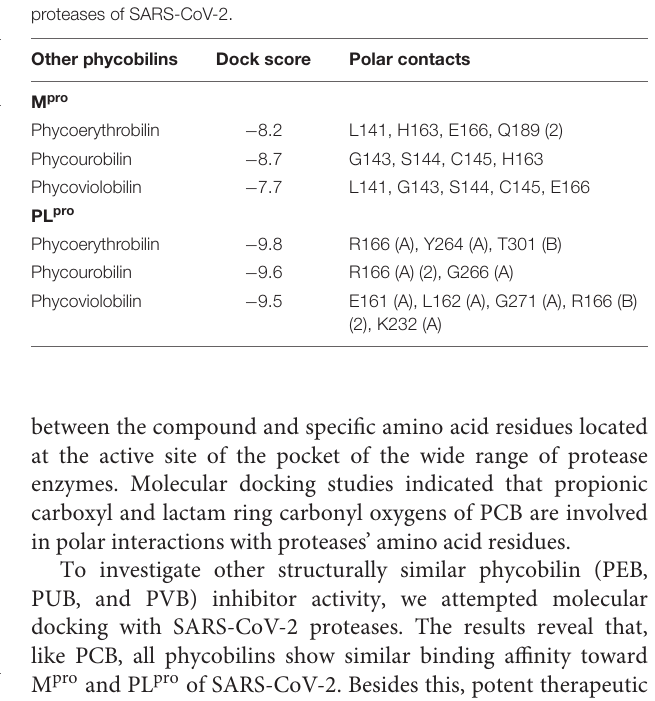
Frontiers in Microbiology |